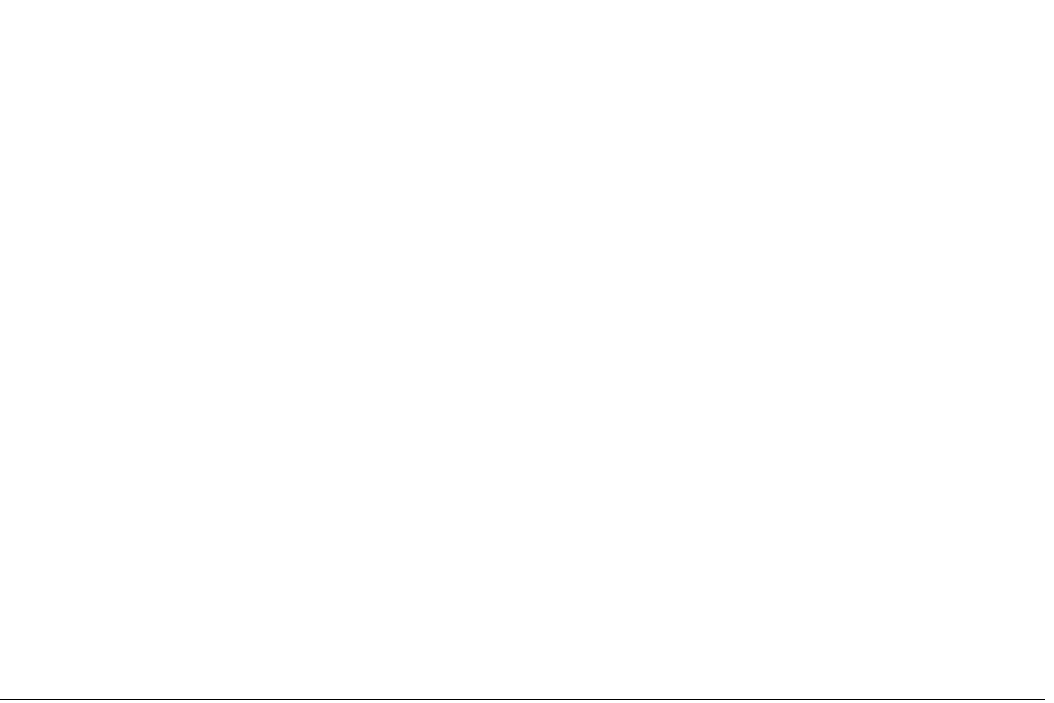
Figure 4. Schematic diagram of DQN model